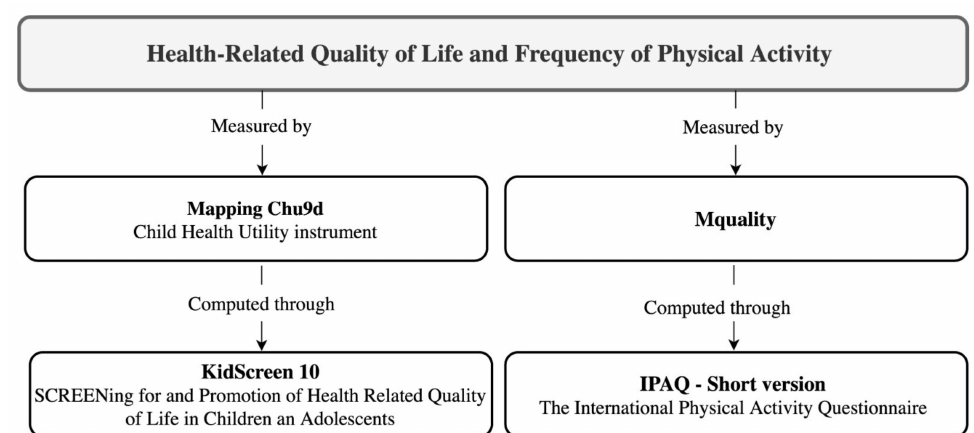
Figure 1. Schematic diagram of main variables and constructs of the